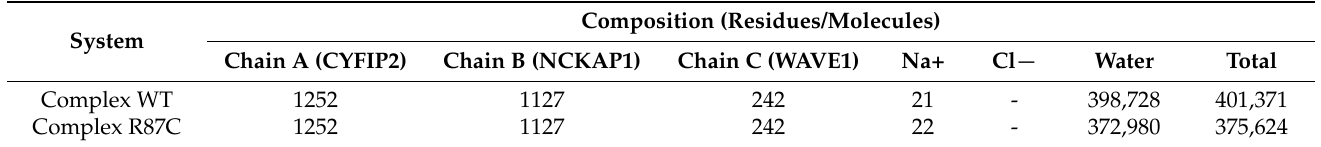
Table 2. The atomic compositions of all simulated